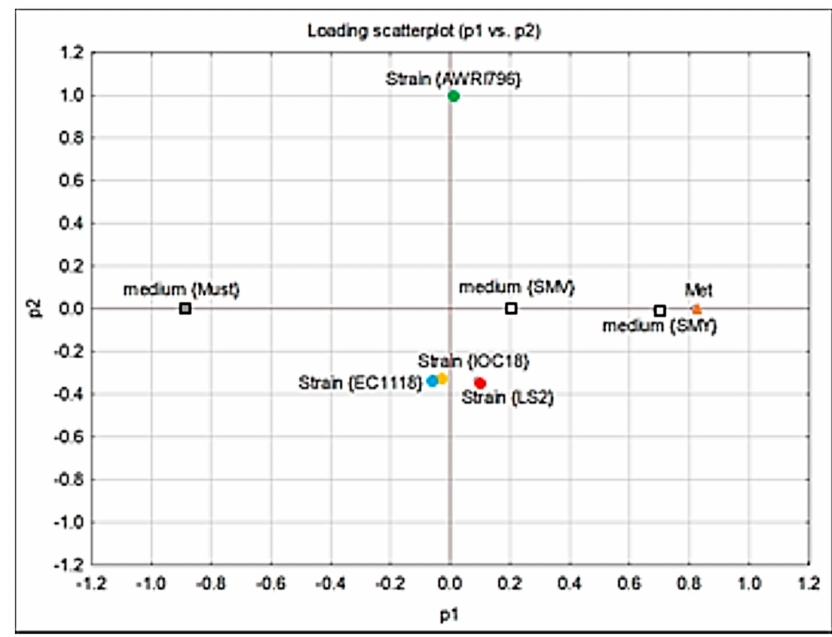
Figure 6. Scatter plot of the PCA analyses regarding the extracellular content of